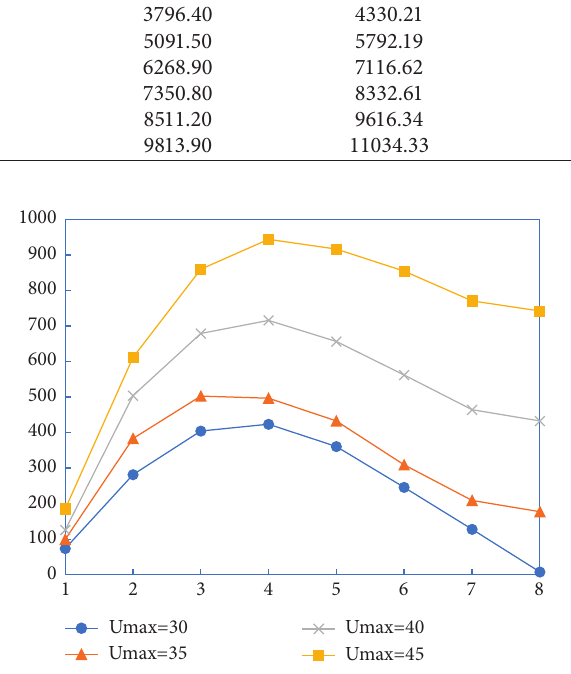
Figure 2: The influence of U